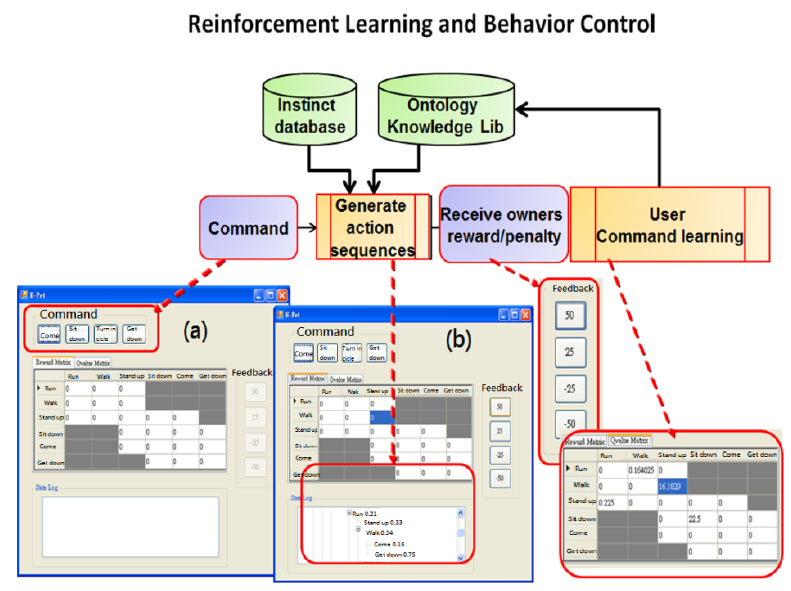
Figure 22. Reinforcement learning and behavior control.